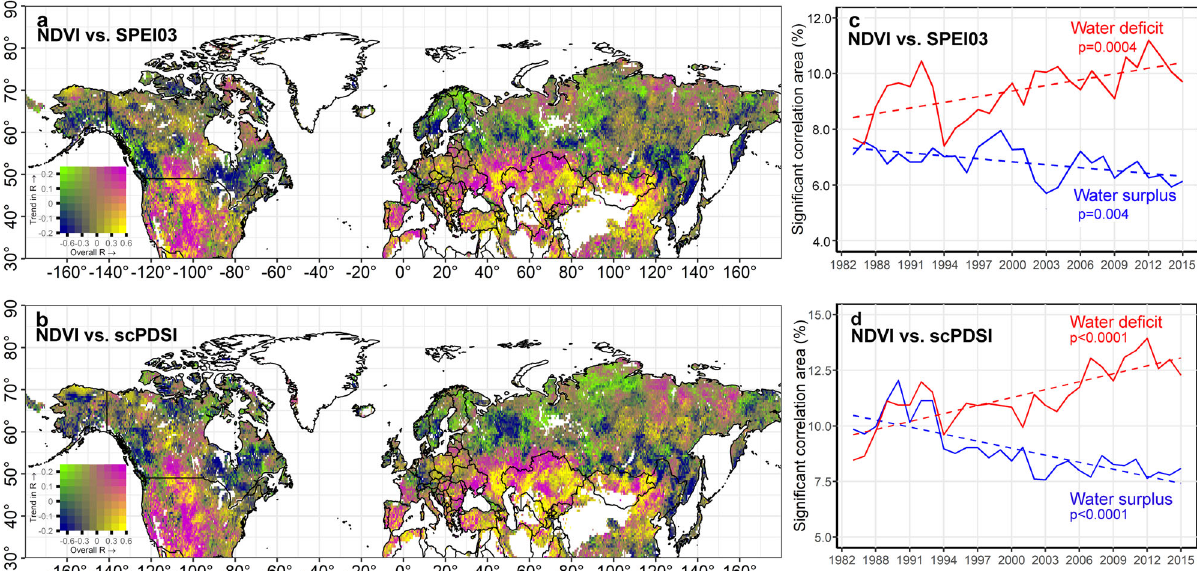
Fig. 2 Spatiotemporal distribution of the statistically signi fi cant correlations between vegetation growth and water availability indices over the last three decades. a , b Show distribution of correlation coef fi cients (R NDVI-SPEI03 and R NDVI-scPDSI ) between normalized difference vegetation index (NDVI) anomaly and 3-month Standardized Precipitation-Evapotranspiration Index (SPEI03) and Palmer Drought Severity Index (scPDSI). The horizontal axis of the color legend is the correlation coef fi cient between NDVI anomaly and SPEI03 (scPDSI) for the entire study period, the vertical axis of the color legend is the trend of correlation coef fi cient for the 30 fi ve-year moving windows, no color indicates unvegetated regions. The chartreuse color stands for vegetation water surplus regions where water surplus has been decreasing; navy color indicates vegetation water surplus regions that have been experiencing an increase in water surplus; magenta color is used for water de fi cit regions that have been seeing an increase in water de fi cit; and regions colored in yellow are characterized by water de fi cit and a decrease in water de fi cit. c , d Show the temporal trends of signi fi cant changes in percentage areas associated with water de fi cit and water surplus responses using 5-year moving windows. Blue color stands for the water surplus response and red color for water de fi cit response. All the trends of water de fi cit and water surplus responses are signi fi cant in linear trend test and Mann – Kendall trend test ( p < 0.05). X-axes of ( c , d ) are binned using 5-year moving window to smooth out time series fl uctuations and highlight the